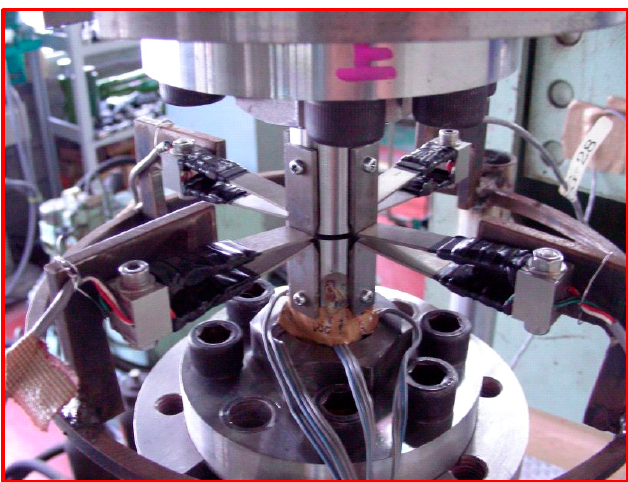
Figure 2. Set up of the specimen with displacement gauge attached for the measurement of opening displacements.